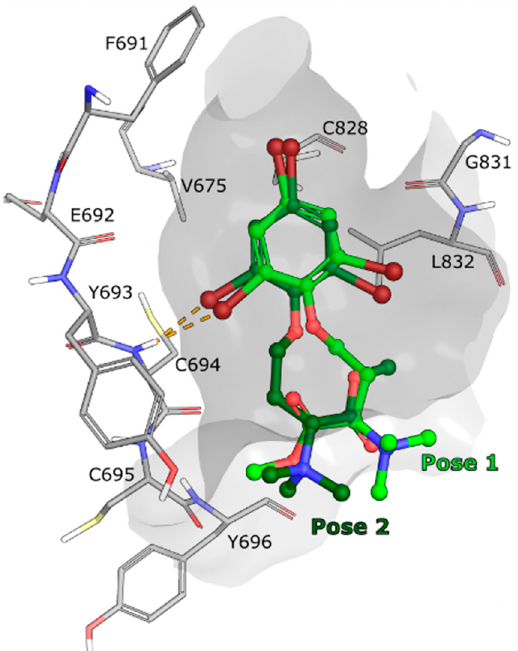
Figure 7. Docking of 1 in the active site of FLT3 WT model PDB ID: 6JQR [35]. Compound 1 is placed in the active site pocket (shown as a grey surface) in two different manners: pose 1 (light green carbon atoms) and pose 2 (dark green carbon atoms), with similar docking scores (both around -5.9, suggesting weak binding). Pose 2 is roughly a 180-degree rotation of pose 1 along the long axis of the molecule. However, none of the poses suggest any specific interaction with FLT3 beyond having dimensions that roughly match its active site cavity. FLT3 residues that are in proximity of 1 are displayed as grey sticks and labelled. Color code for non-carbon atoms: hydrogen atoms are shown in white, nitrogen atoms in blue, oxygen atoms in red, sulfur atoms in yellow and bromine atoms in maroon. The orange dashed lines represent too-close contacts.